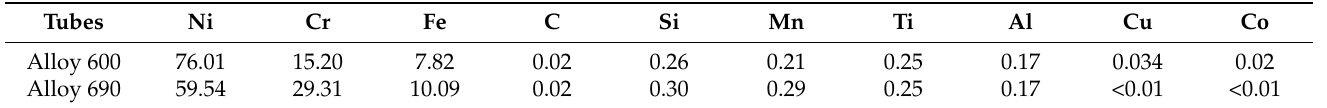
Table 1. Chemical compositions of Alloy 600 and Alloy 690 tube materials